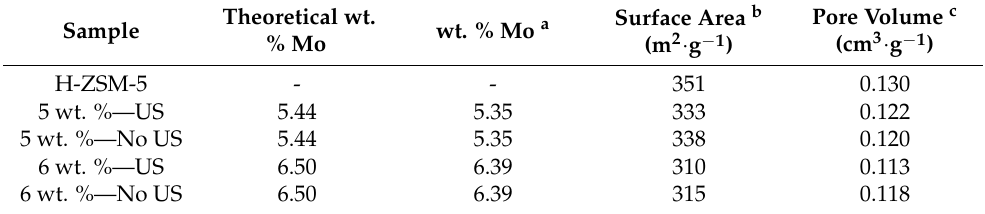
Table 1. Summary of physical-chemical properties of the parent zeolite and the different Mo/ZSM-5 catalysts prepared with ultrasound (US) and without ultrasound (No US). Theoretical wt. Surface Area wt. % Mo a Sample % Mo